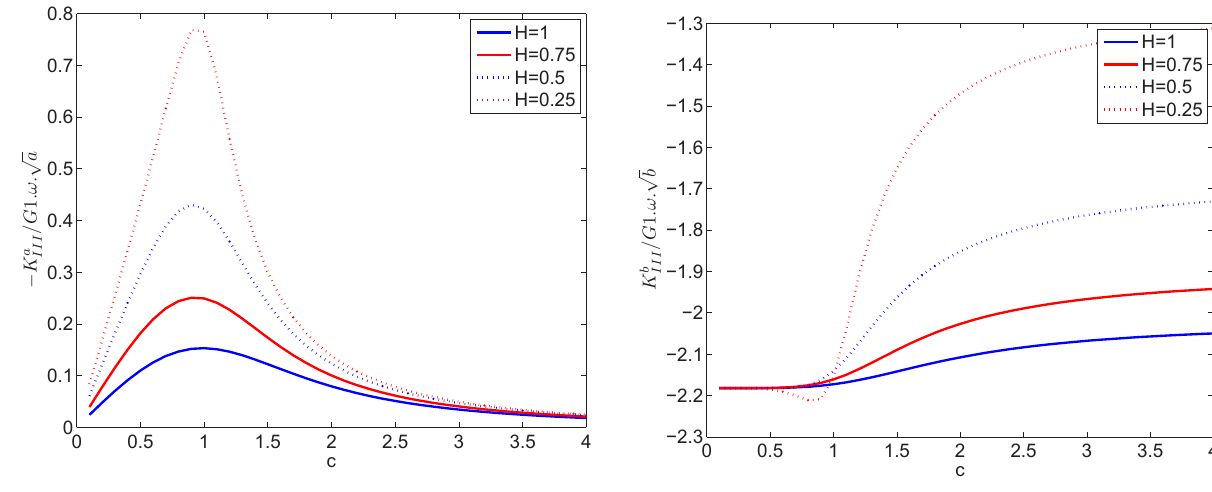
Figure 3: Variation of the normalized stress intensity factor at the edge of the crack with G